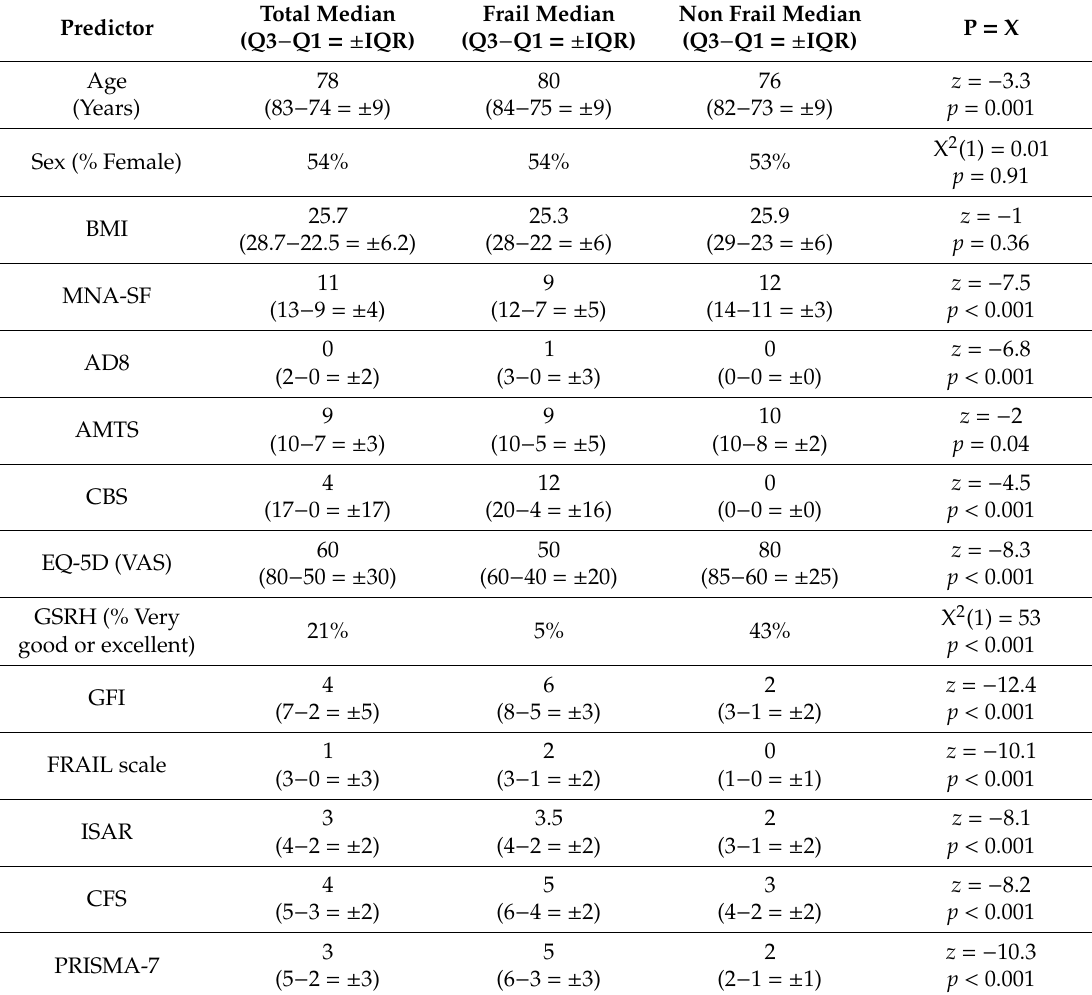
Table 1. Characteristics of patients ( n = 265) screened for frailty comparing those classified as frail and non-frail (based on the comprehensive geriatric assessment